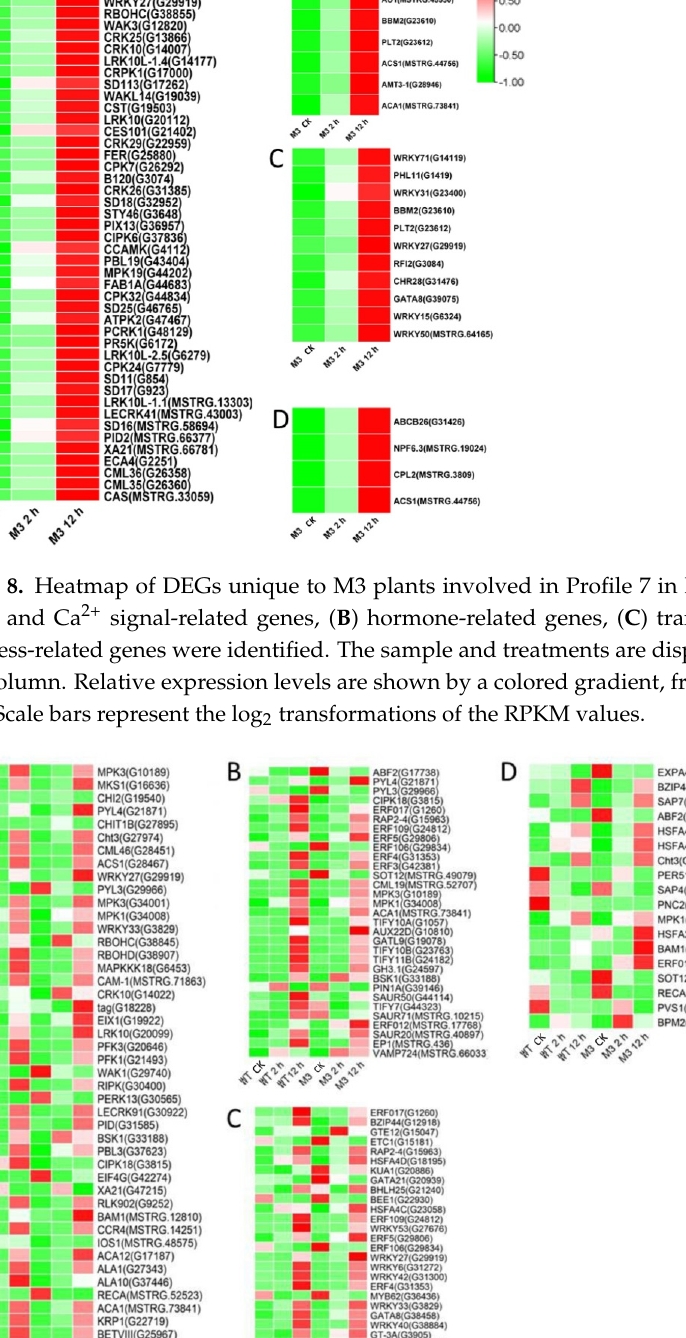
Figure 7. Heatmap of DEGs unique to M3 plants involved in Profile 4 in M3 plants. ( A ) Protein kinase and Ca 2+ signal-related genes, ( B ) hormone-related genes, ( C ) transcription factors, and ( D ) stress-related genes were identified. The sample and treatments are displayed at the bottom of each column. Relative expression levels are shown by a colored gradient, from low (green) to high (red). Scale bars represent the log 2 transformations of the RPKM values.